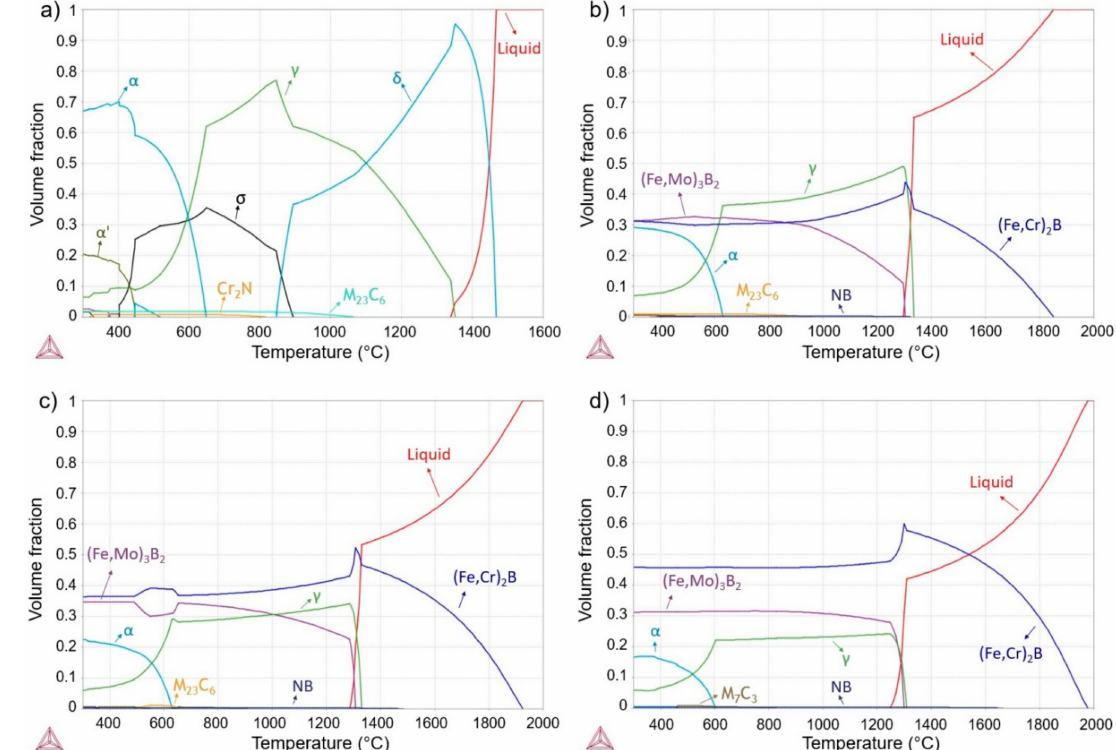
Figure 4. Equilibrium phase evolution with the temperature of the alloy ( a ) without boron addition (i.e., of the SAF superduplex stainless steel); ( b ) with 3.5 wt.% B; ( c ) with 4.5 wt.% B and ( d ) with 5.5 wt.%